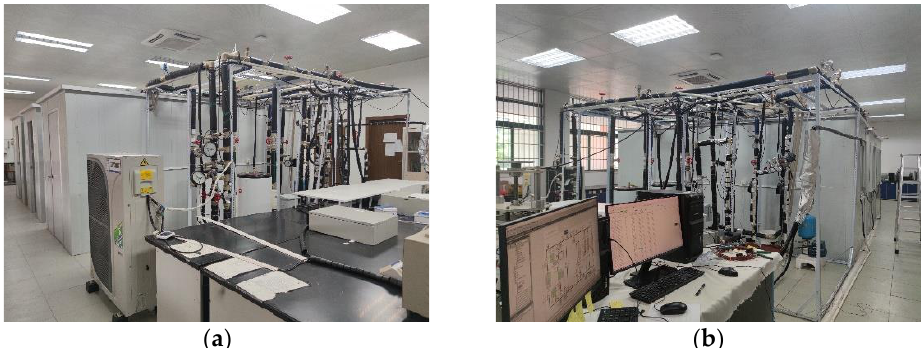
Figure 1. The appearance of the left(a) and right (b) sides of the experimental platform, respec-